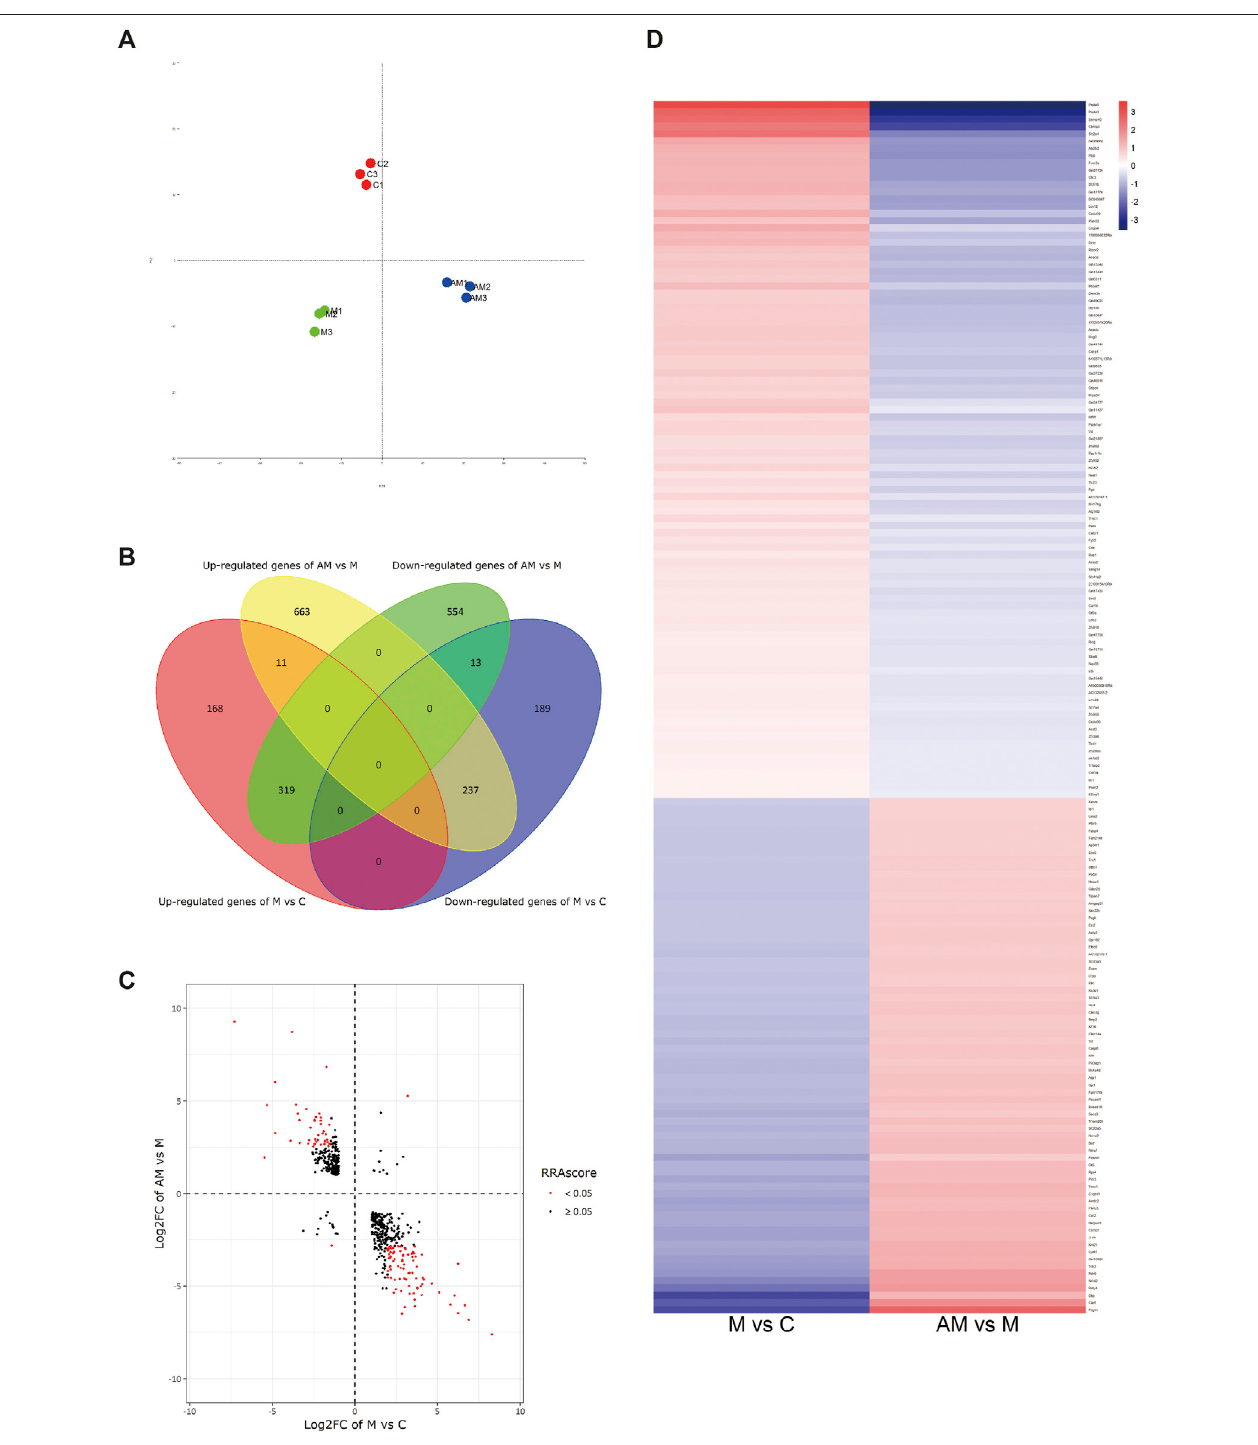
FIGURE 3 | (A) Principal correlation analysis. (B) Venn diagram of DEGs. (C) Volcano plot diagram: the fi rst and third quadrants show the genes both up- and downregulated in both METH and antibiotic-pretreated groups, the second quadrant shows the genes downregulated in the METH group but upregulated in the AM group, and the fourth quadrant shows the genes upregulated in the METH group but downregulated in the AM group. (D) Heatmap diagram of DEG analysis among groups. The blue color represents downregulation, while red represents upregulation. C, control group; M, METH group; AM, antibiotic + METH group.